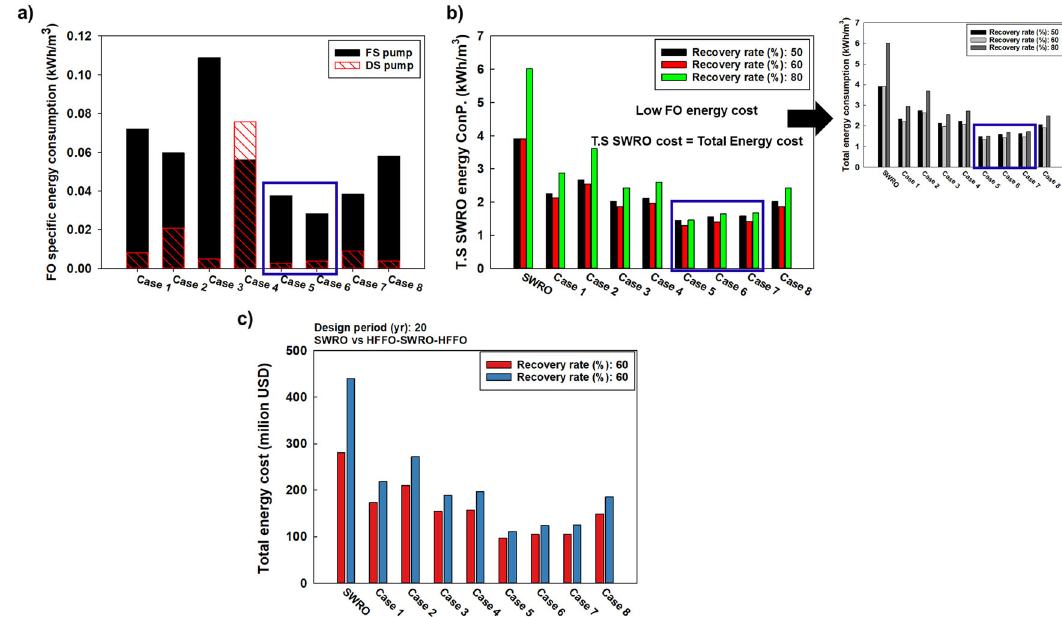
Fig. 4 Energy consumption values (SEC) compared with two-stage RO process at the different recovery rates. Panels a , b show the energy consumption values (SEC) compared with two-stage RO process at the different recovery rates. Panel c shows the total energy cost of the FO – RO – HFFO process compared with the RO process at 60 and 80% recovery rate.